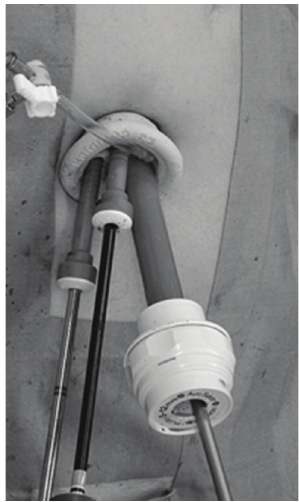
Figure 1: External view of SILS Port. Easy replacement of a 5mm port with a 12 mm port is one of the advantages of this port.